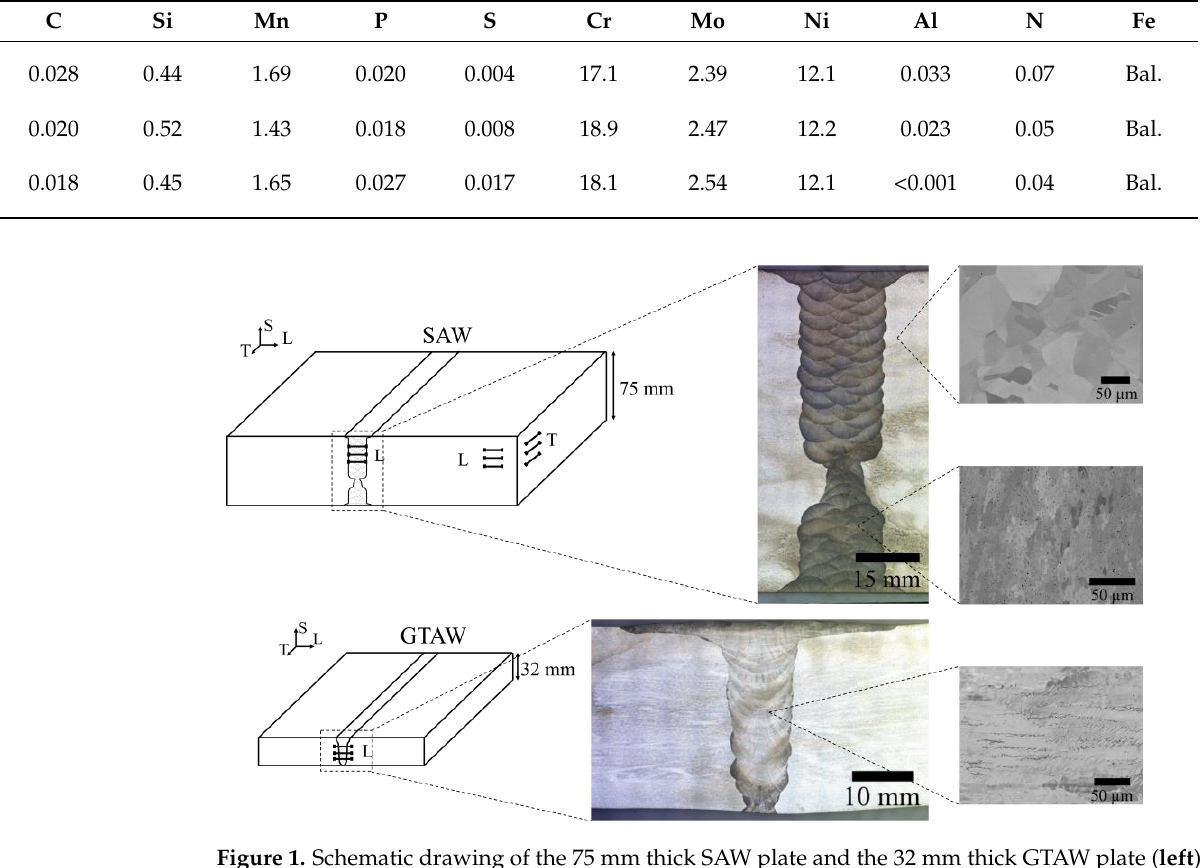
Table 1. Chemical composition of the materials used in this work, as measured by OES (in wt.%).